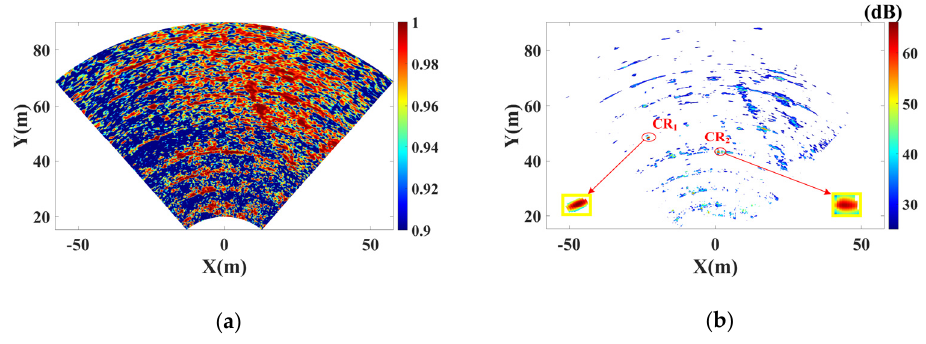
Figure 10. ( a ) Average coherence map; ( b ) Permanent scatterer (PS) selection